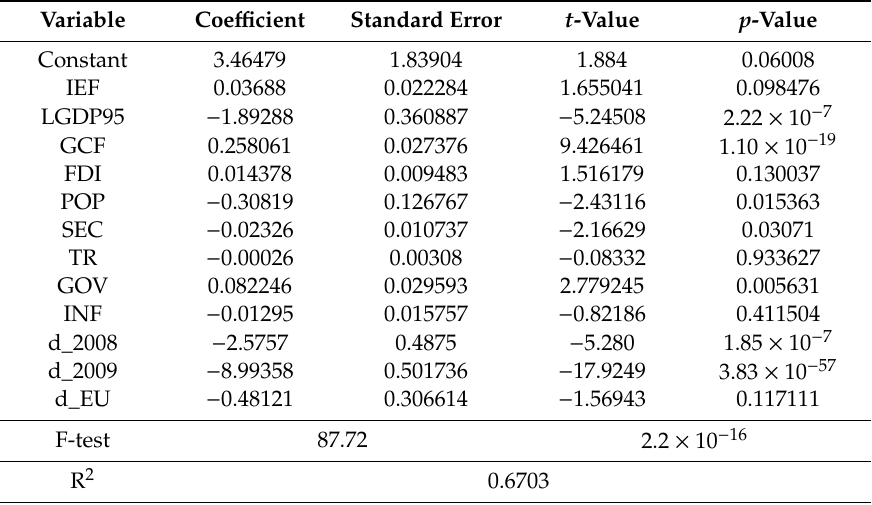
Table 4. Results from the least squares dummy variable (LSDV)